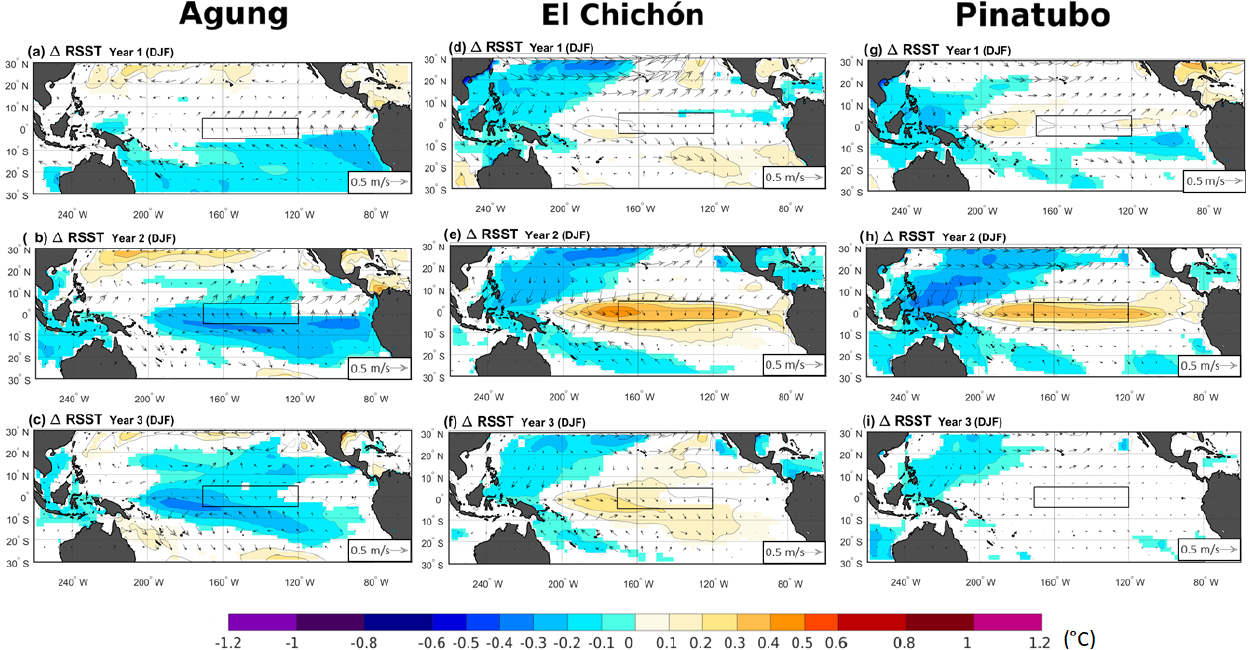
Figure 2. Ensemble mean of changes in relative sea surface temperature (RSST) (shadings) and 10m winds (arrows) between the volcano case and the climatology for each of the following three winter seasons (DJF) after the Agung (a–c) , El Chichón (d–f) , and Pinatubo (g–i) eruptions. Only significant RSST changes are shaded with an approximate 95% confidence level using Student’s t test. Contours show the RSST anomalies following the colour bar scale (solid lines for positive anomalies and dashed lines for negative anomalies; the 0 line is omitted). The boxes indicate the Niño 3.4